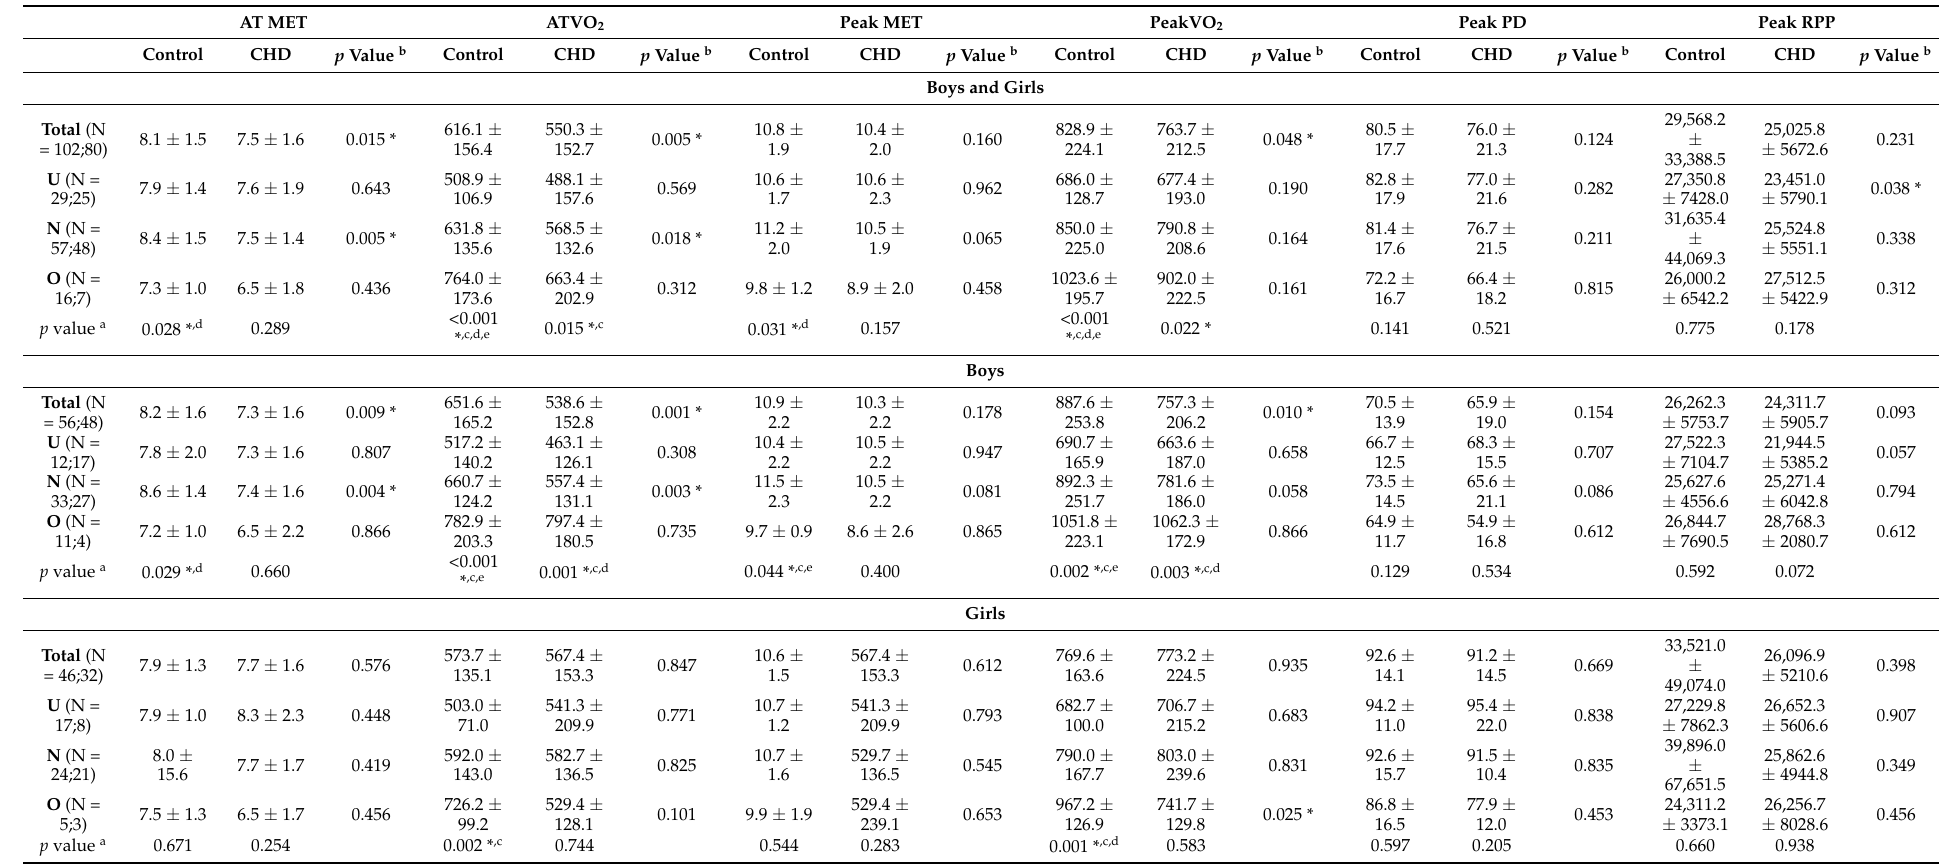
Table 2. Comparisons of cardiopulmonary fitness between subjects with underweight, normal, and overweight body mass index. AT MET ATVO 2 Peak MET PeakVO 2 Peak